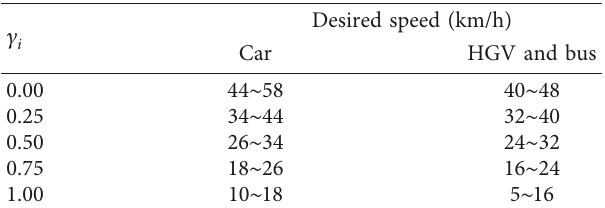
Figure 7: Speed characteristics of different positions on the investigated section. Table 3: Matching results between the PD degree and the desired